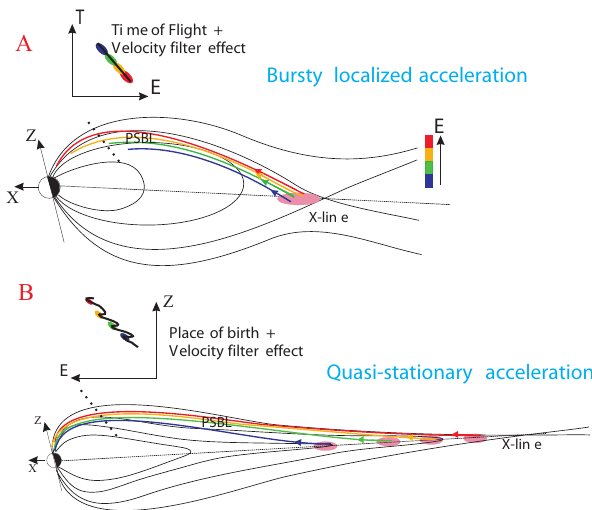
Fig. 23. Two schemes for the formation of ion dispersion in the PSBL. (A) Transient ion acceleration at a localized source located near an X-line (indicated by the pink oval) results in ions with wide distributions of parallel energies (E) being ejected into the PSBL. In this case the dispersion is mostly formed by the Time-of-Flight and Velocity Filter effects. (B) Quasi-stationary ion acceleration in the wide vicinity of an X-line at multiple localized resonant sources; ions ejected from each particular resonance will have a relatively narrow distribution of their parallel energies. In this case the dis- persion in the PSBL will be formed due to Place of Birth and Ve- locity Filter effects and multiple localized beams (beamlets) may be observed.